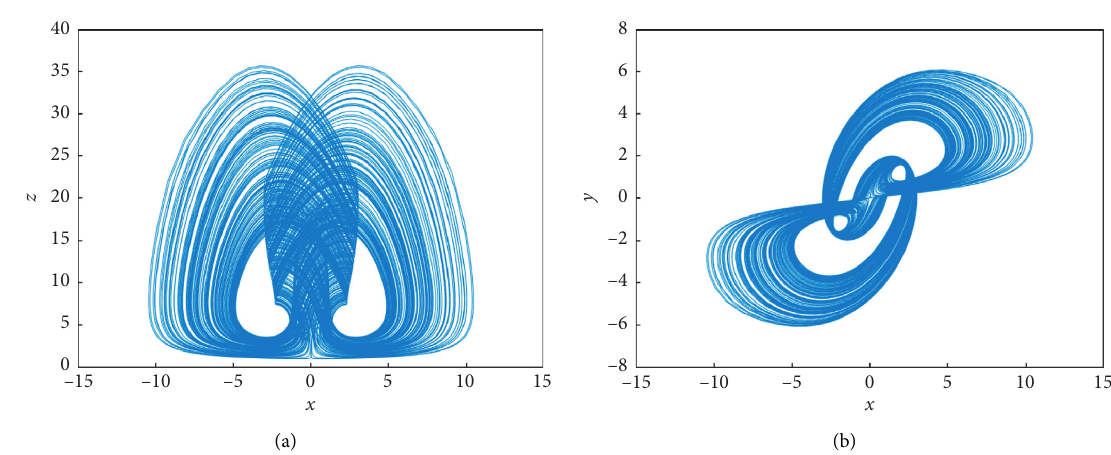
Figure 2: Phase portraits of the fractional system with α � 0 . 95.